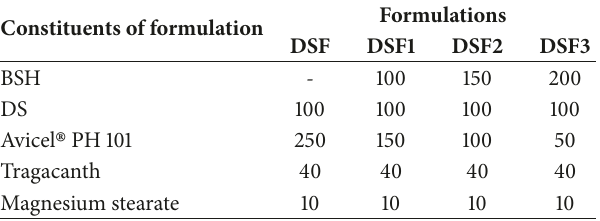
Table 1: Composition (mg) of BSH tablet formulation. Constituents of formulation